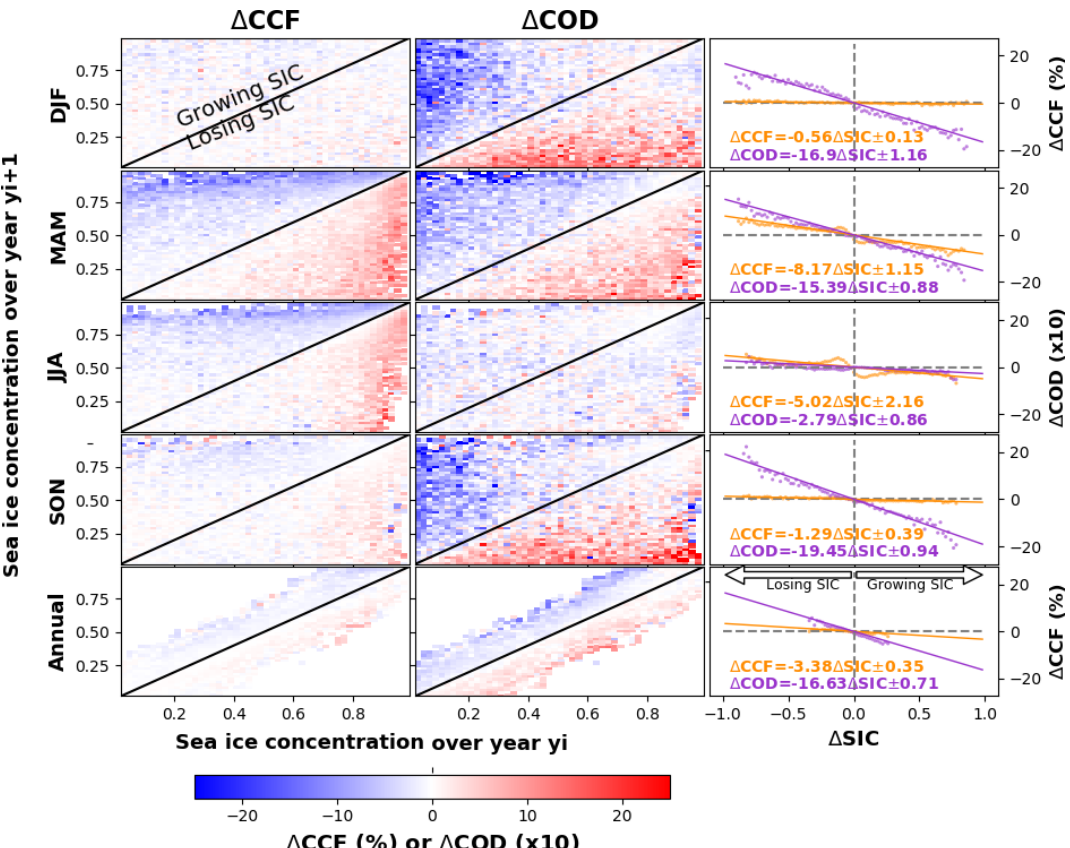
Figure 6. Seasonal and annual changes in cloud cover fraction (CCF) and cloud optical depth (COD) over the Antarctic polar sea region as a function of SIC change between 2 consecutive years, y i + 1 and y i , from the 2001 to 2016 time period. In order to use the same scale, COD has been multiplied by a factor of 10. The top triangles in the two first columns refer to the increase (growing) in SIC, while the blue colours mean a reduction in CCF or